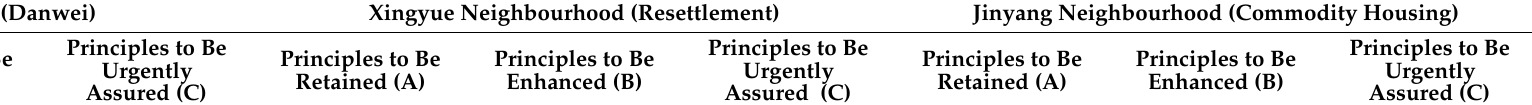
Table A3. Contextual principles of neighbourhood planning